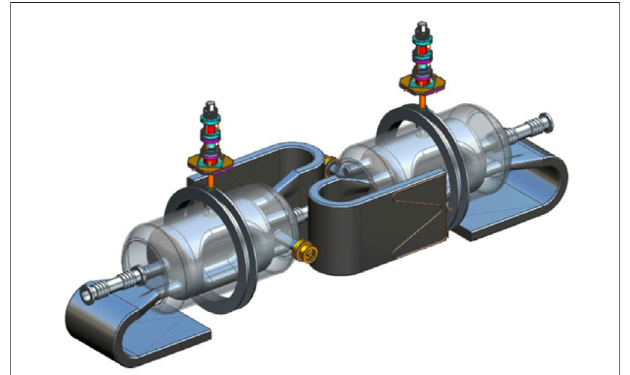
FIGURE 11 | 3D model of the RFD cavity concept showing two cavities with HOM waveguides